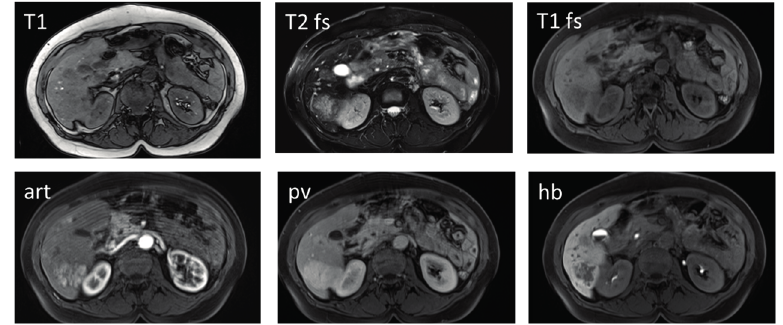
Figure 4. A 47-year old female patient with focal nodular hyperplasia (FNH). Image series obtained before and after administration of hepatocyte specific contrast media is